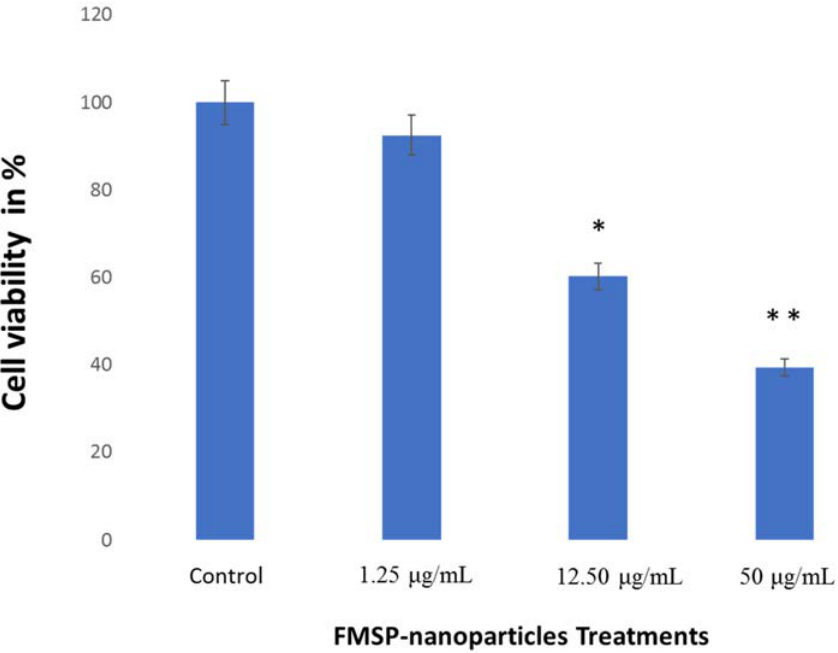
Figure 10. Cell viability analysis. The MCF-7 cells were treated with FMSP-nanoparticles with various concentrations (1.25 µ g/mL, 12.50 µ g/mL, and 50 µ g/mL) for 24 h. Data are the means ± standard deviation (SD) of three different experiments. Differences between two treatment groups were analyzed where * p < 0.05 and ** p < 0.01.